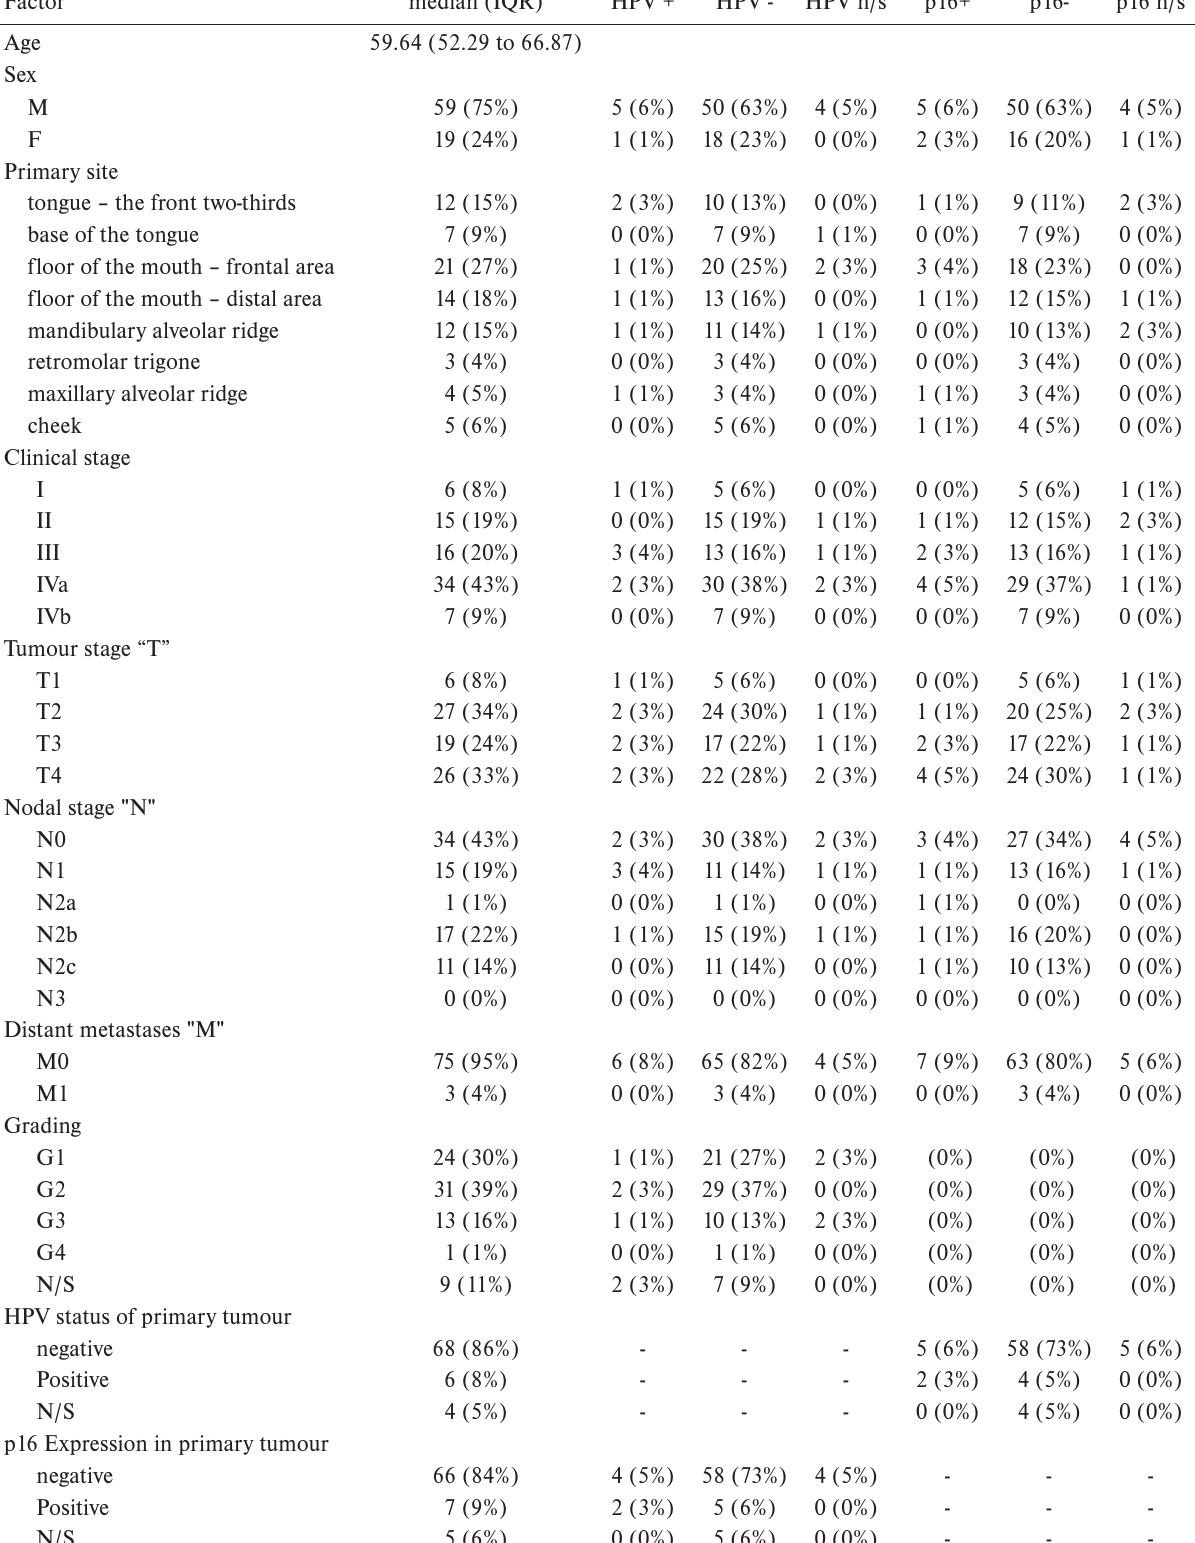
Table 1. Baseline characteristics of the study patients and their